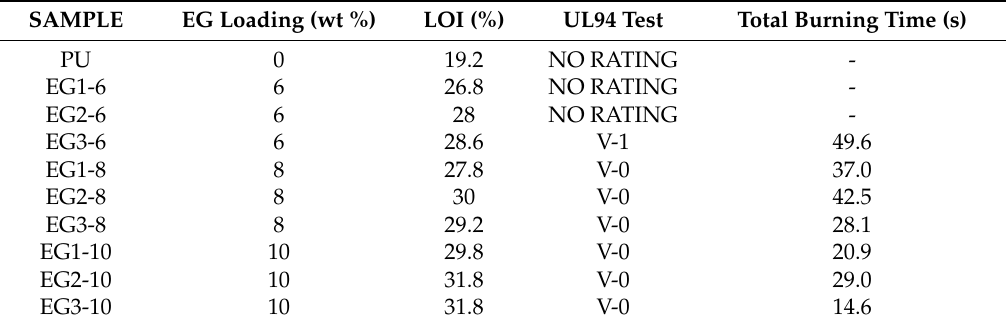
Table 4. Limited oxygen index (LOI) and vertical burning (UL94) tests results of EG/PU